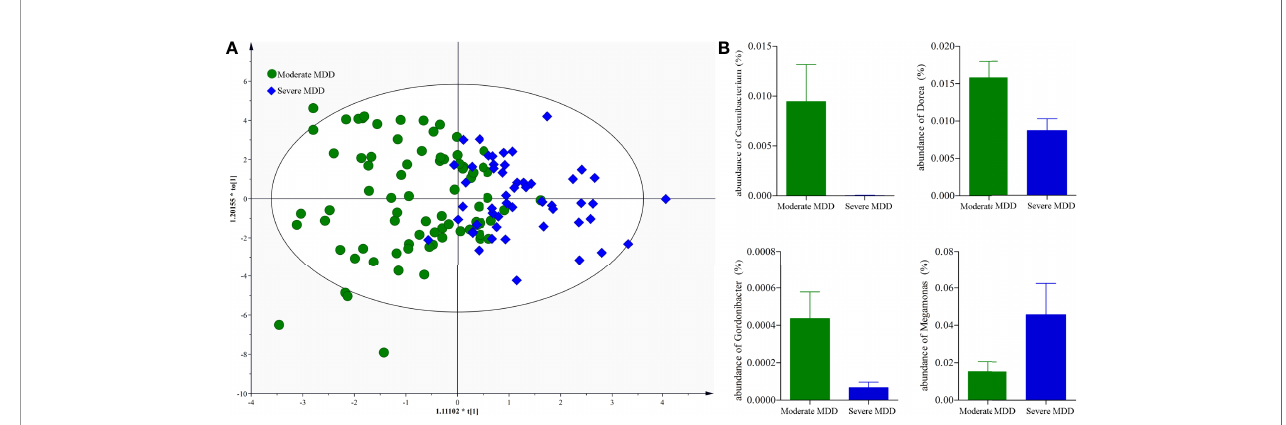
FIGURE 5 | Genus-level analysis of gut microbiota between moderate and severe MDD patients. (A) OPLS-DA model showed that the moderate and severe MDD patients could not be signi fi cantly separated; (B) there were four differential genera between the